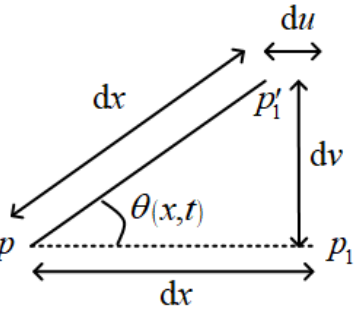
Figure 2. Schematic of the geometry and the in-extensibility condition.